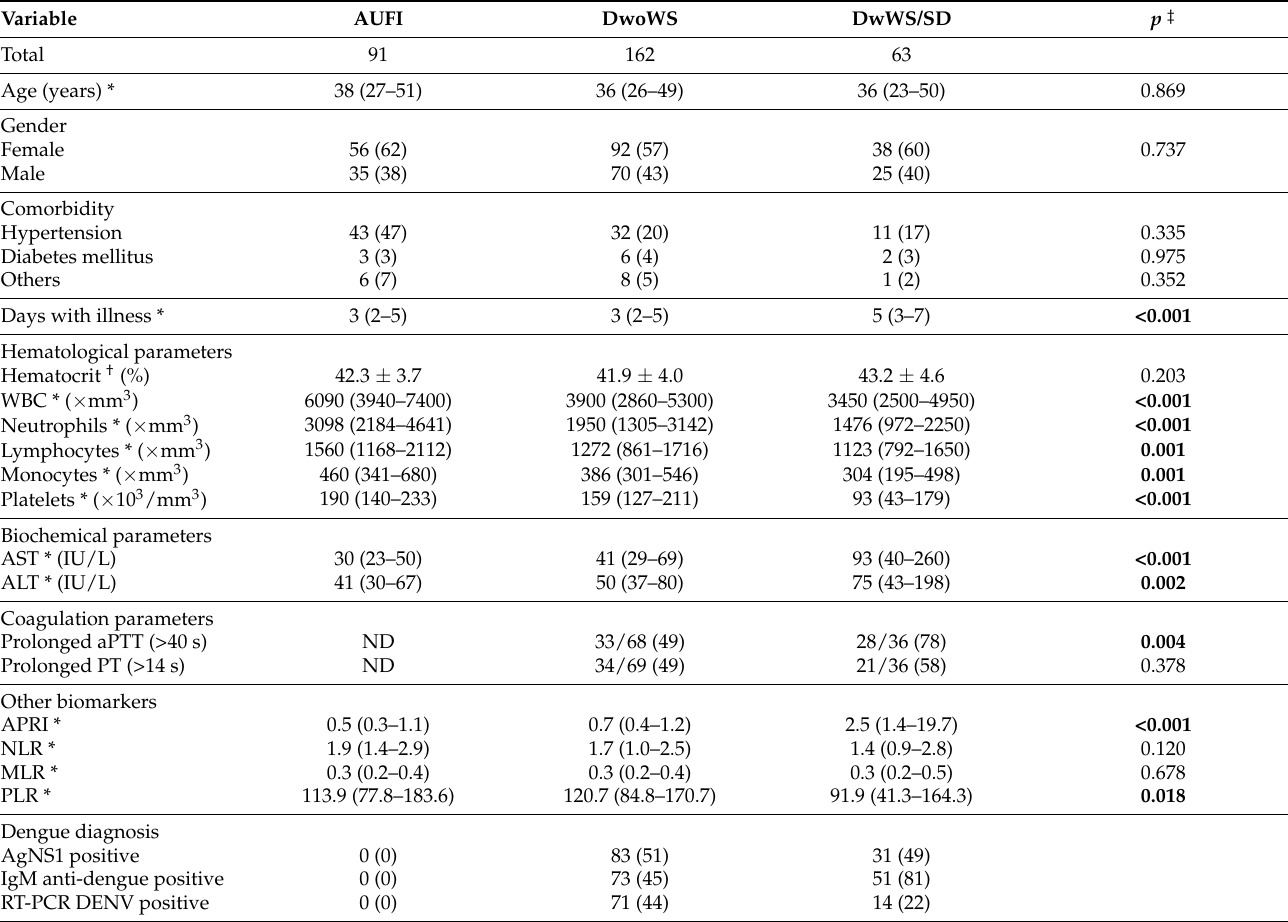
Table 1. Baseline characteristics and laboratory parameters of dengue and AUFI